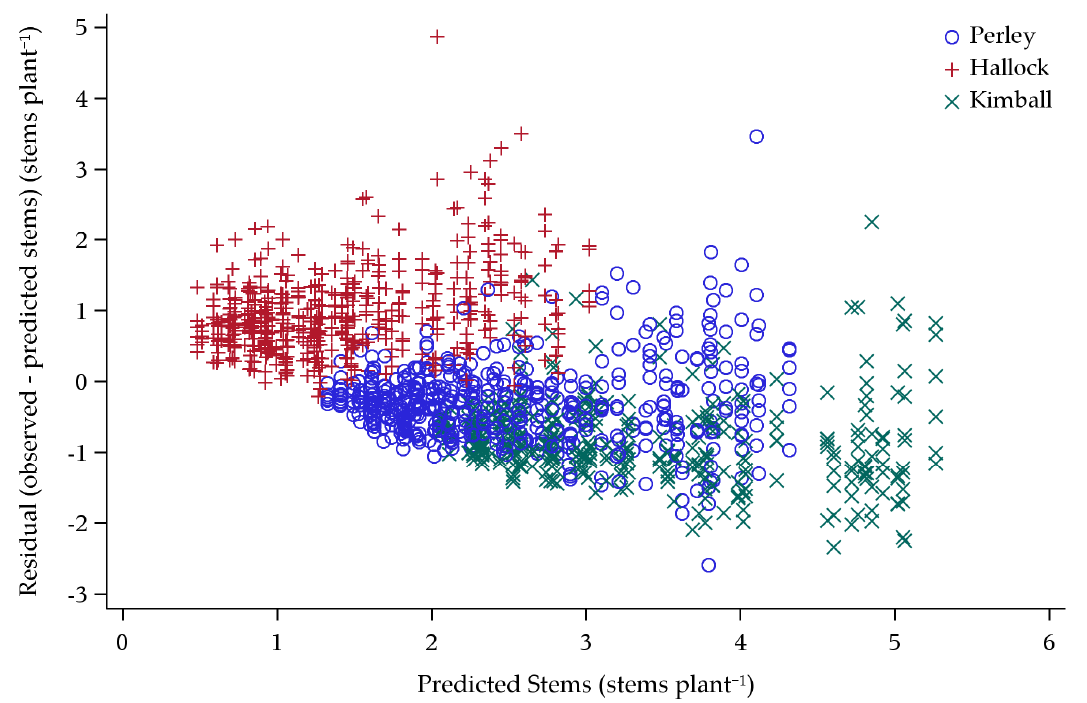
Figure 5. Validation dataset stems per plant predictions plotted against residual stems per plant (observed minus predicted stems per plant) for 2013–2015 locations near Kimball, Perley, and Hallock, Minnesota. Agronomy 2020 , 10 , 332